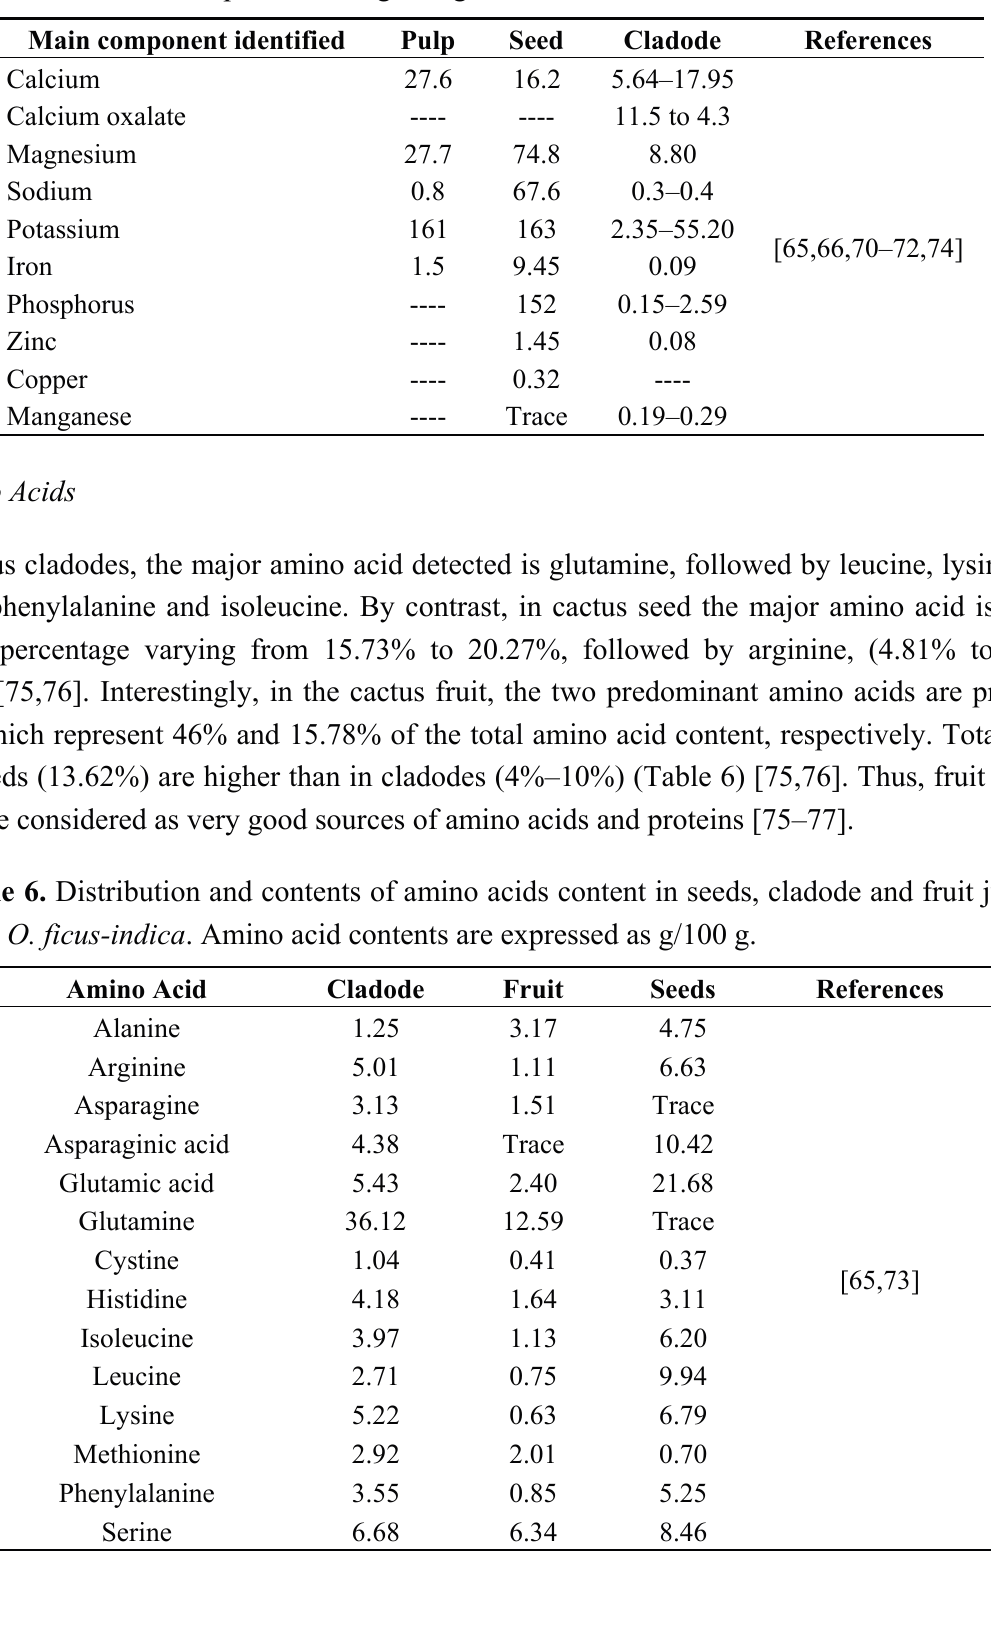
Table 5. Distribution and contents of minerals in the various parts of O. ficus-indica . Mineral contents are expressed as mg/100 g.